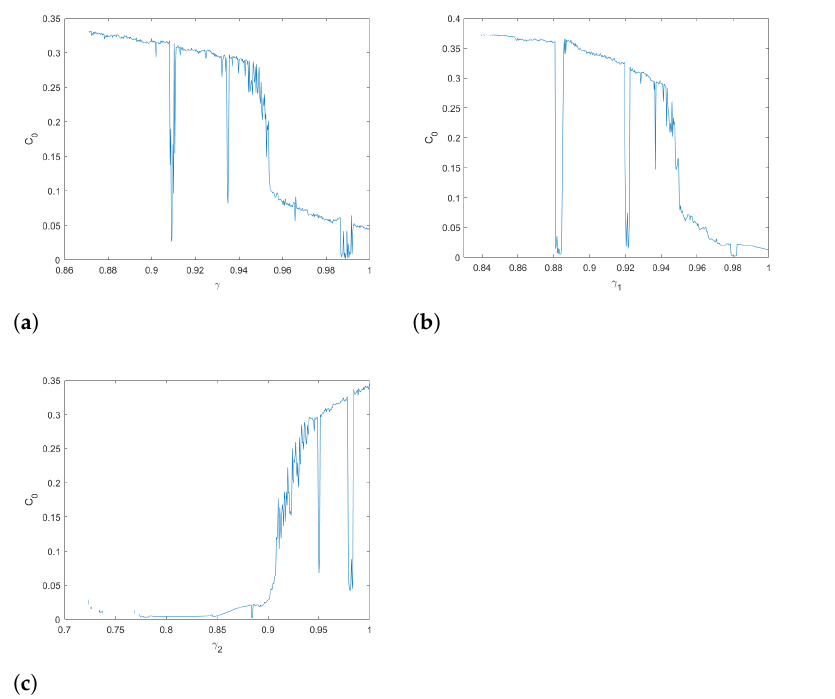
Figure 15. C 0 complexity analysis of the SIR epidemic model (11) for α = 4 and ( S ( 0 ) , I ( 0 )) = ( 70,30 ) and with fractional-order values: ( a ) γ 1 = γ 2 , ( b ) γ 1 = 0.94, and ( c ) γ 2 = 0.94. Table 2. Approximate entropy test of the SIR model (11) with different fractional-order values γ i , i =